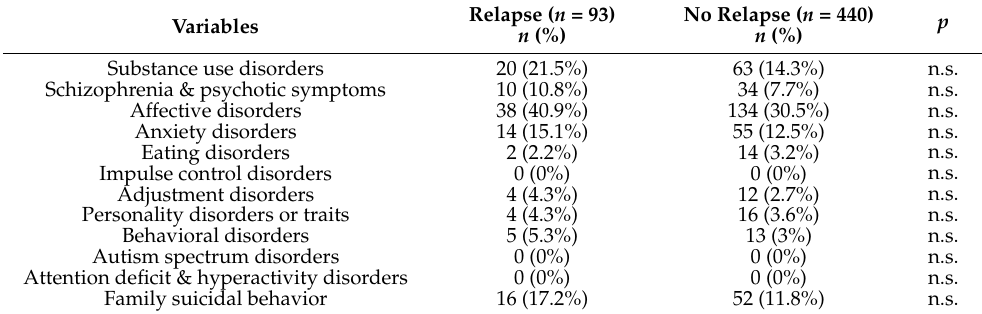
Table 4. Family background of the sample.